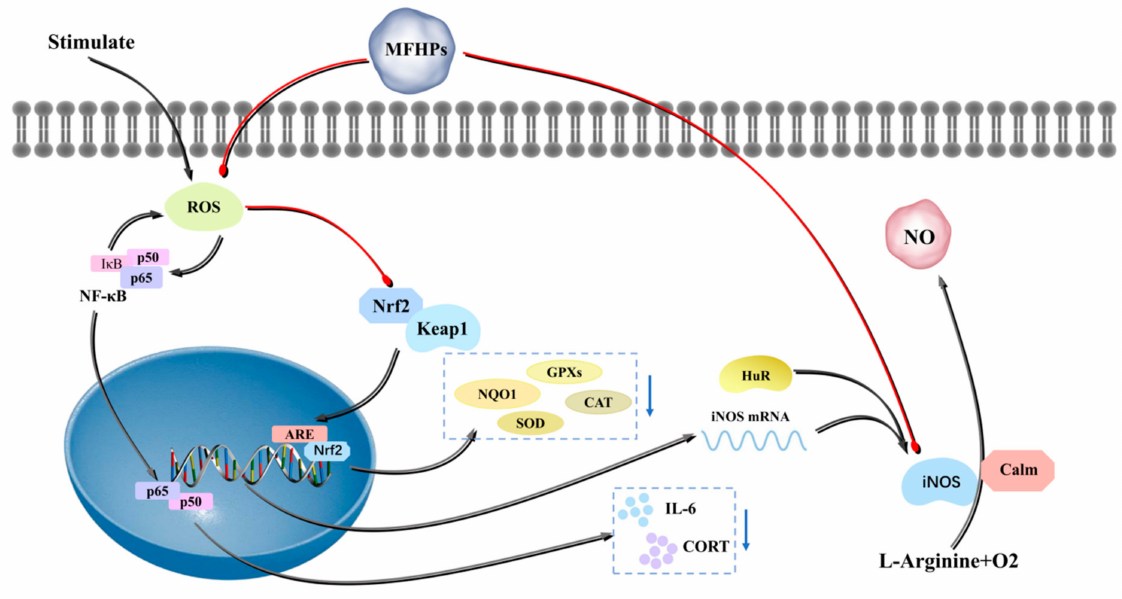
Figure 3. Antioxidant mechanism of